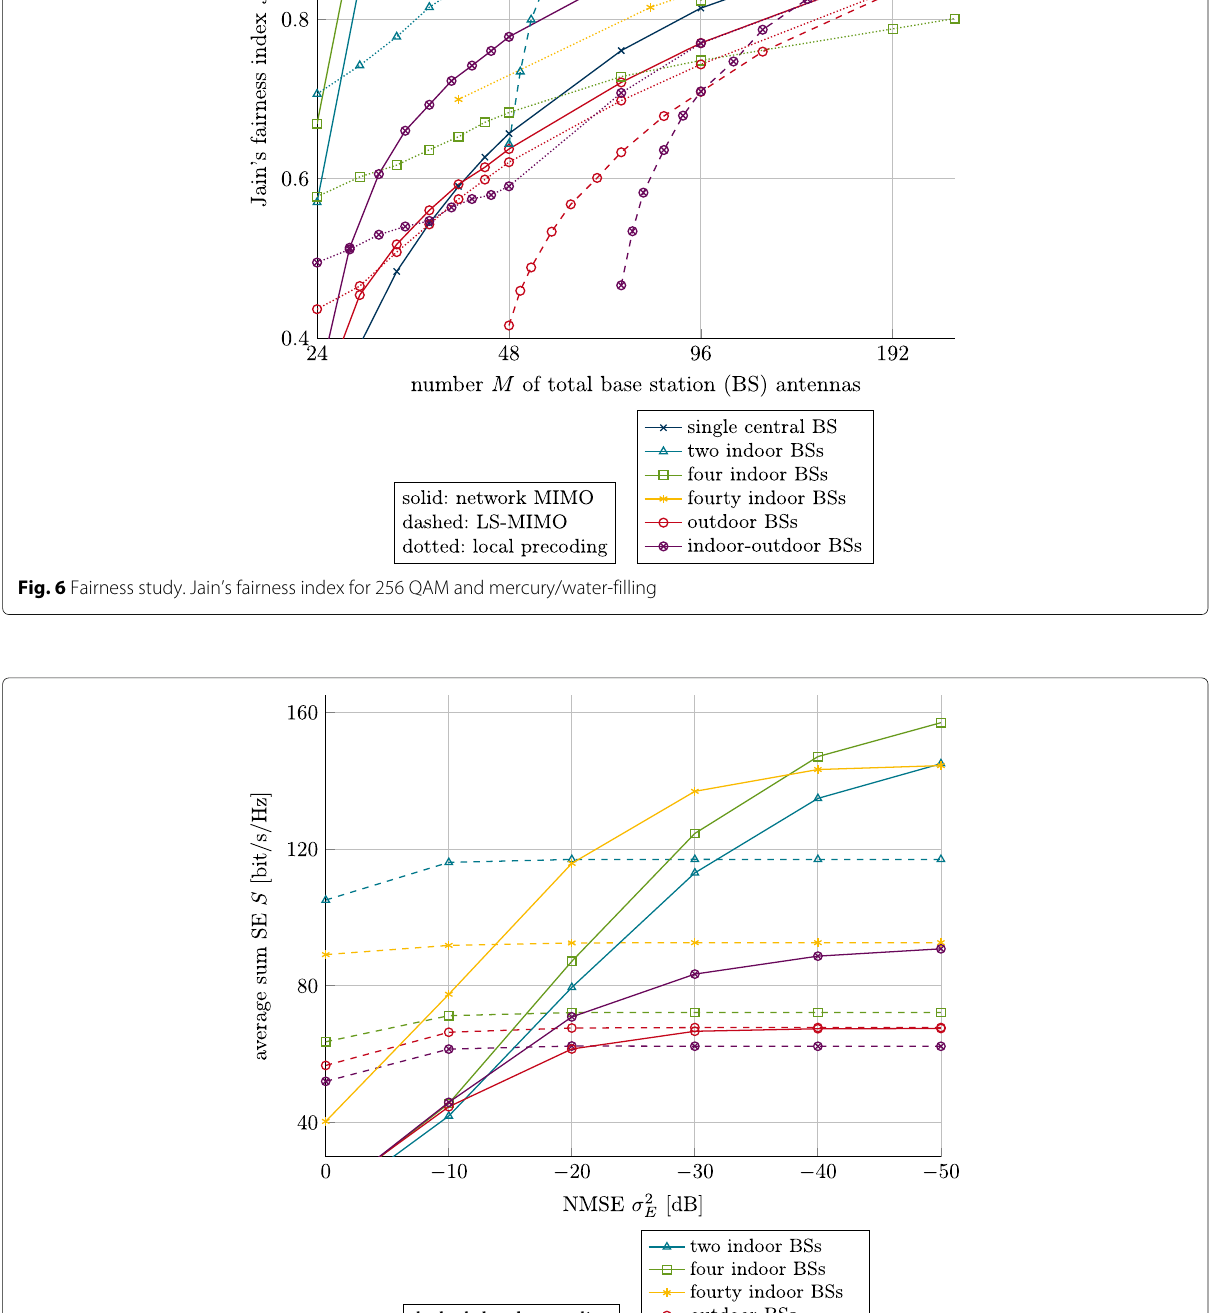
Fig. 7 Noisy channel estimation. Average SE with 48 total BS antennas (with 40 total BS antennas for the fourtyindoorBSs deployment) for a zero-mean Gaussian distributed channel estimation